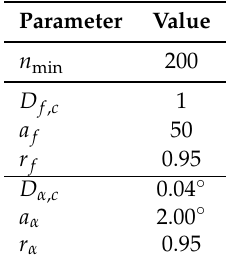
Table 1. Overview of the values of all parameters mentioned in this manuscript and used in our experiments. For the parameters related to the C-EFIC method, we refer to